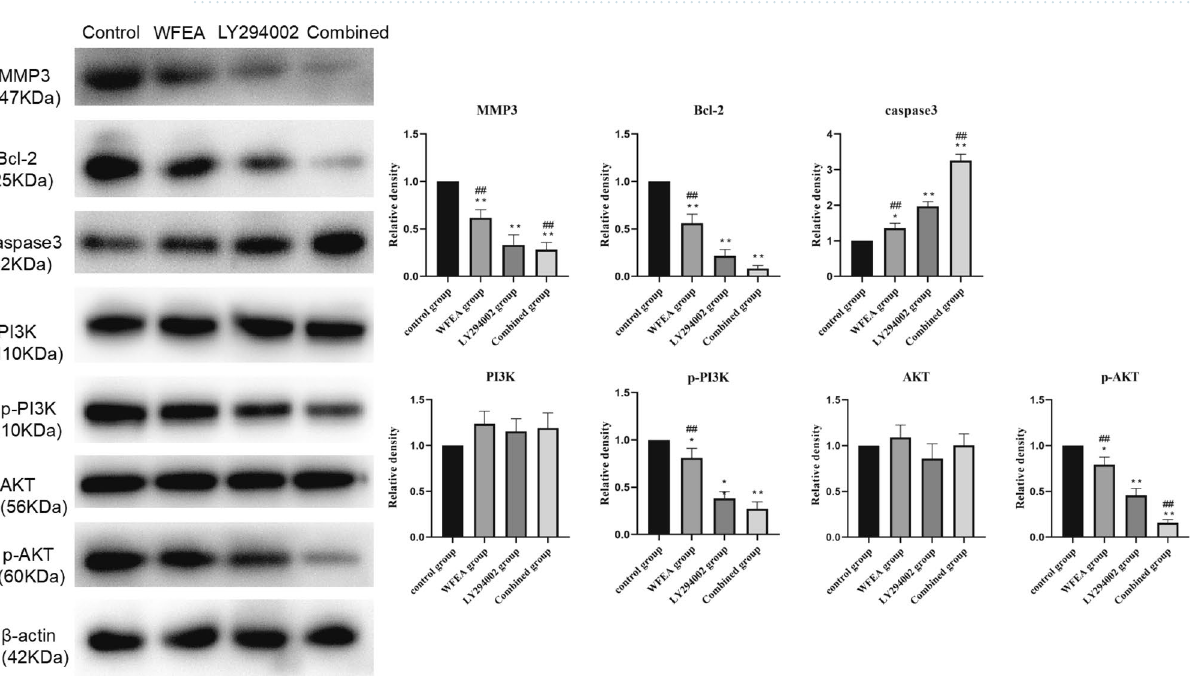
Figure 11. Effects of WFEA on the protein expression of related factors in the PI3K-AKT signaling pathway. N = 3 and 3 biological replicates; * p < 0.05 and ** p < 0.01 compared with blank group, ## p < 0.01 compared with LY294002